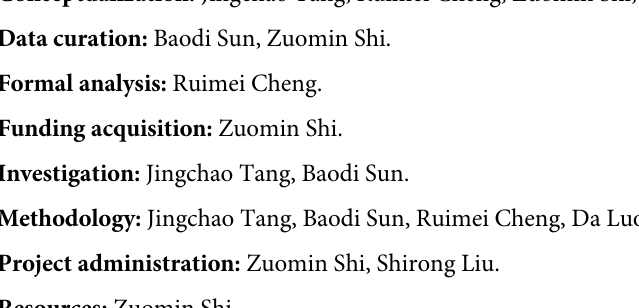
S2 Table. Quantity of leaf N (per area and per mass) allocated to Rubisco ( Q ), Rarea, Q Rmass bioenergetics ( Q ), light-harvesting components ( Q ), photosyn- Barea, Q Bmass Larea, Q Lmass thetic apparatus ( Q ), cell wall ( Q ), and other parts ( Q Parea, Q Pmass CWarea, Q CWmass Other-area, Q Other-mass ) in four species seedling leaves. Mean values ( ± SD) were shown (n = 7). Different letters indicated significant differences between species (Tukey’s test, P < 0.05). Statistically